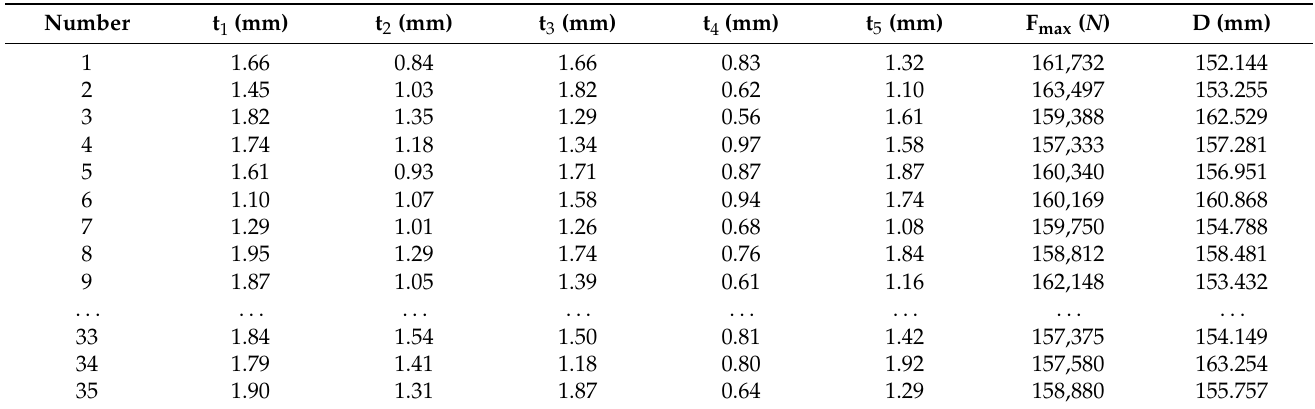
Table 3. 35 sample points and relative response